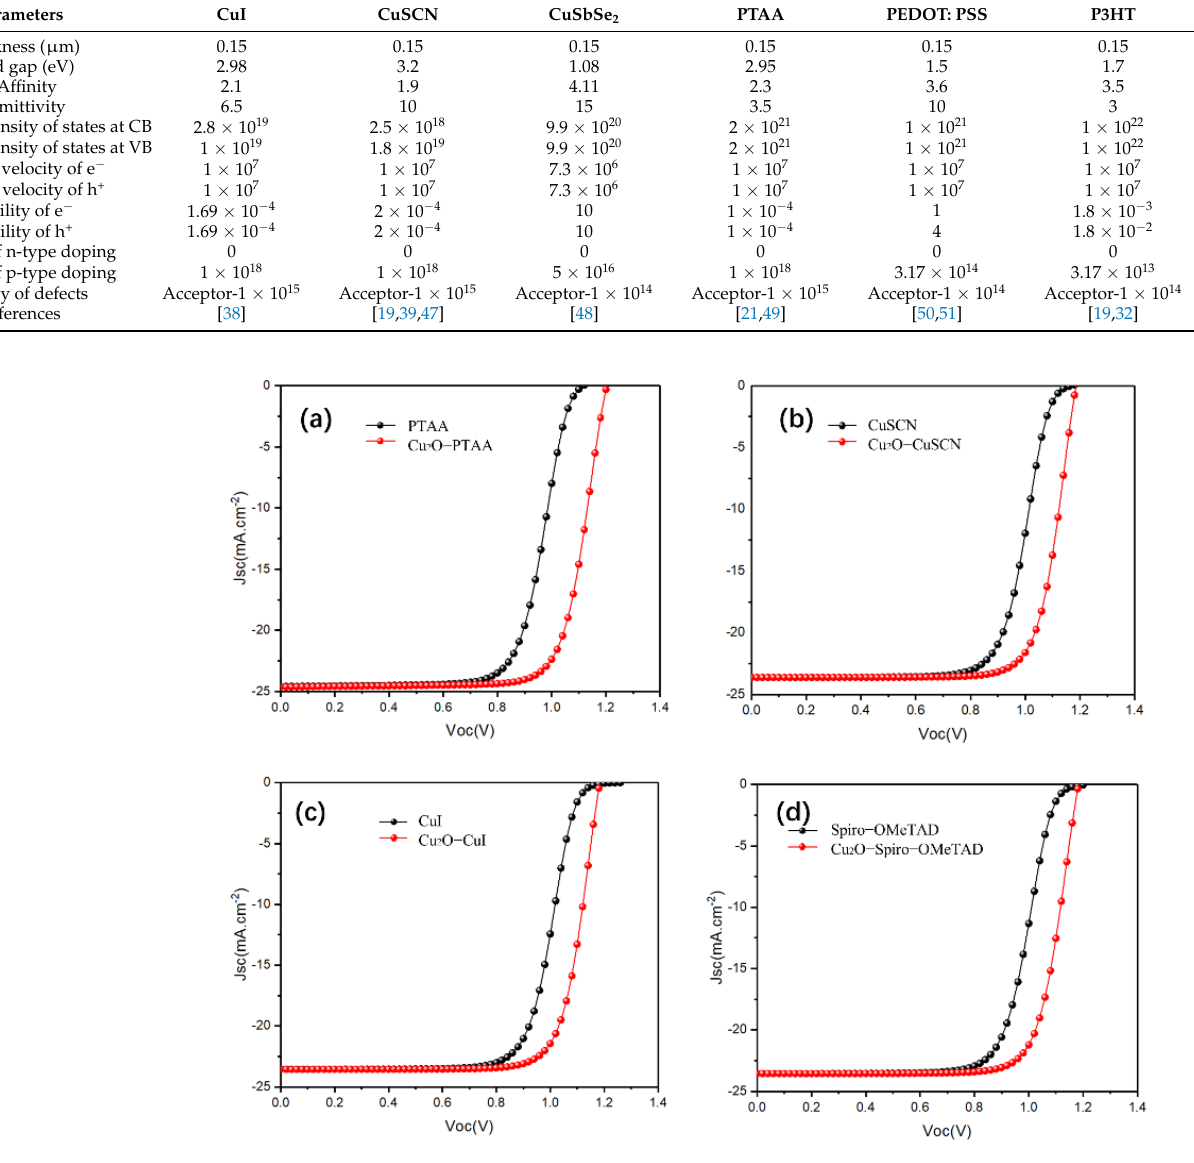
Figure 4. ( a – d ) The current density-voltage ( J–V ) characteristic curves of both device structures (with and without a Cu 2 O buffer layer) with PTAA-HTL ( a ), CuSCN-HTL ( b ), CuI-HT ( c ), Spiro-OMeTAD ( d ).